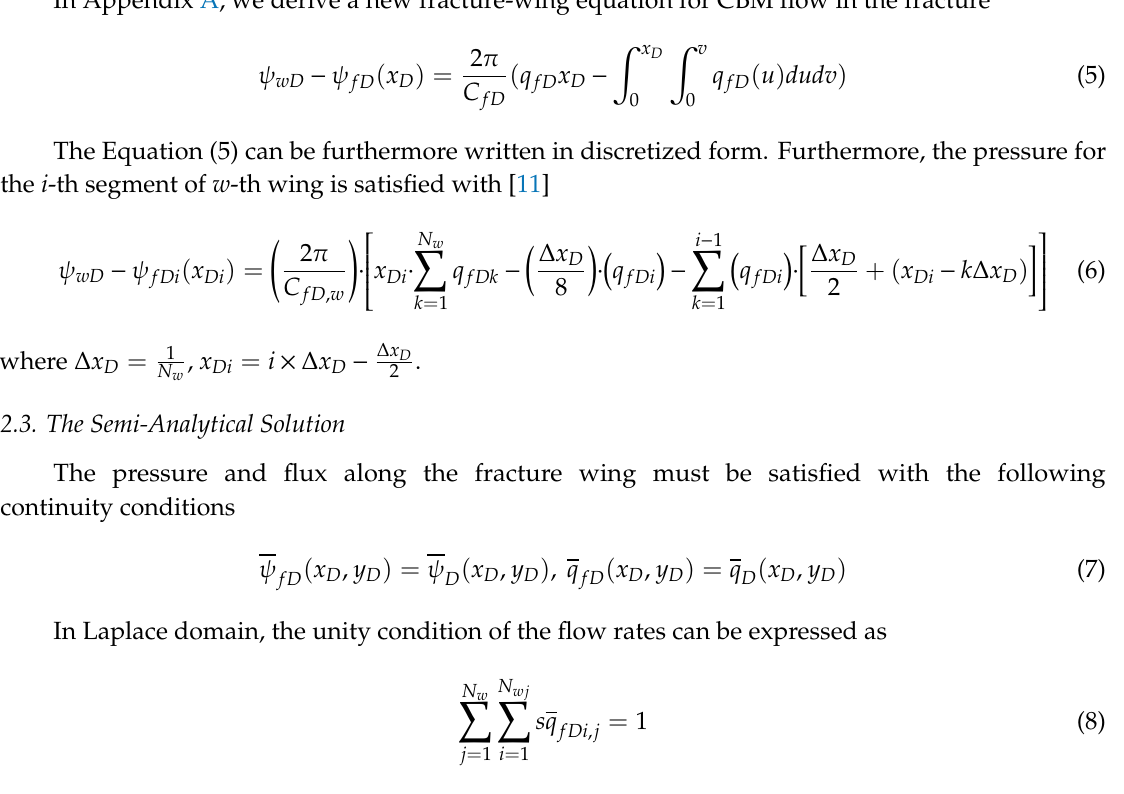
Figure 2. Schematic of fluid flow in a wing.